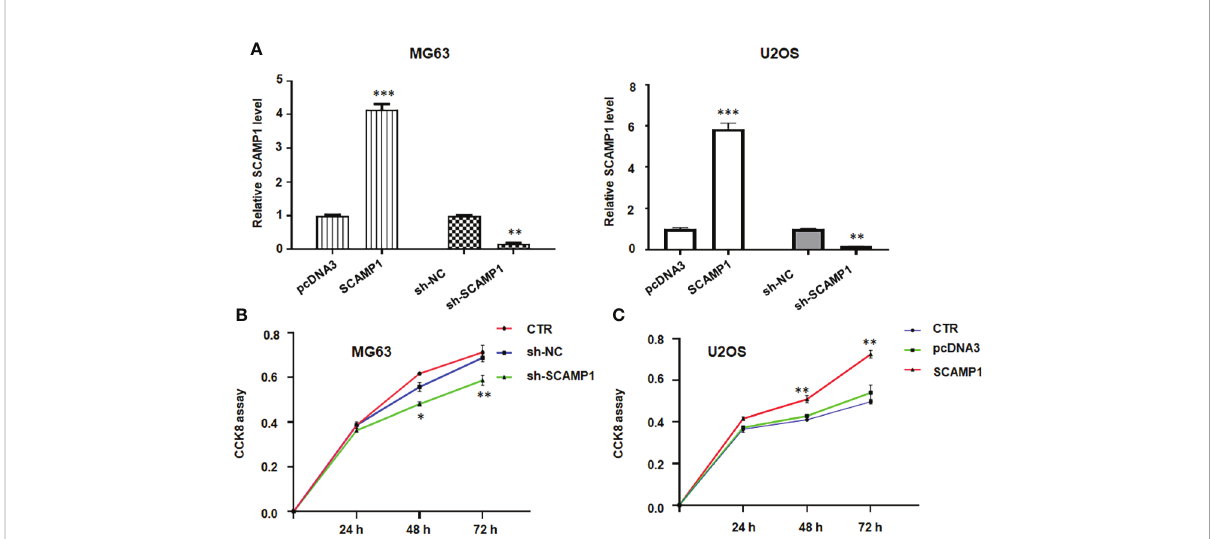
FIGURE 1 LncRNA SCAMP1 overexpression stimulates viability of osteosarcoma cells. (A) : RT-PCR data showed that SCAMP1 cDNA transfection increased the SCAMP1 expression, while sh-SCAMP1 transfection decreased the expression of SCAMP1 in MG63 and U2OS cells. (B) : CCK8 assays showed that sh-SCAMP1 transfection reduced viability of MG63 cells. (C) : CCK8 assays showed that SCAMP1 cDNA transfection induced viability of U2OS cells. *p<0.05; **p<0.01; ***p<0.001 vs. control group. CTR: control; sh-NC: shRNA negative control; sh-SCAMP1: shRNA SCAMP1; SCAMP1: SCAMP1